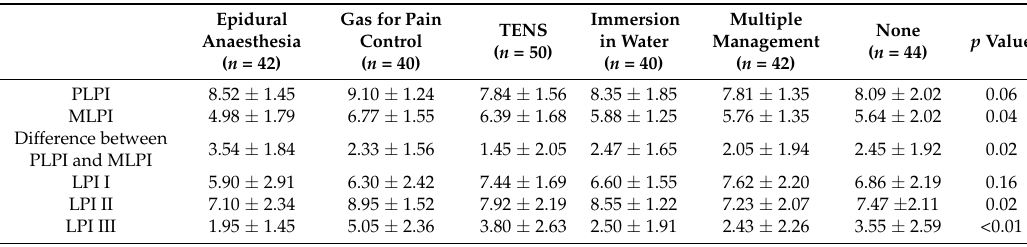
Table 3. Comparison of pain assessment at different stages of labour stratified by chosen pain relief